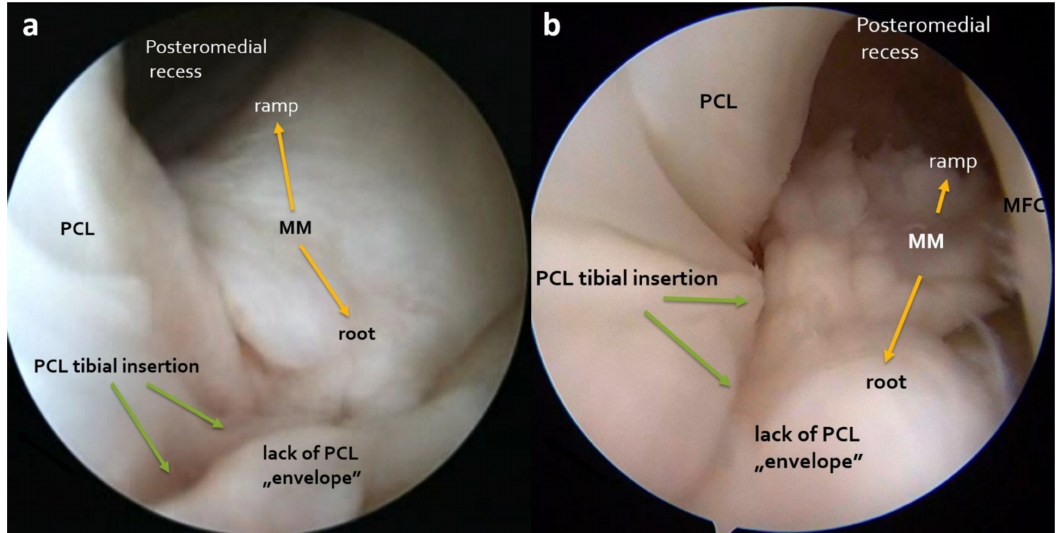
Figure 2. Arthroscopic view from an anterolateral viewing portal in a right knee joint. Trans-notch maneuver. ( a ) Positive PCL envelope lack sign. PCL tibial insertion starting at the level of joint line without a natural space between the PCL and tibia and medial meniscus (MM) posterior root adjacent to the PCL can be observed. ( b ) The same phenomenon seen from a different angle. MFC—medial femoral